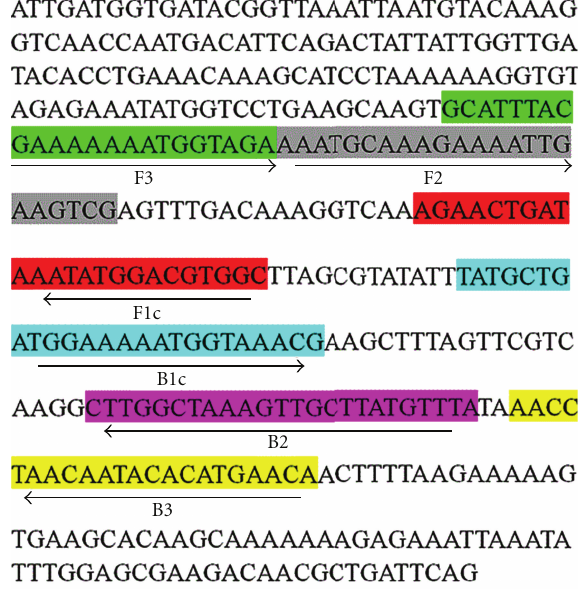
Figure 1: Sequences of LAMP primers in nuc gene of Staphylococcus